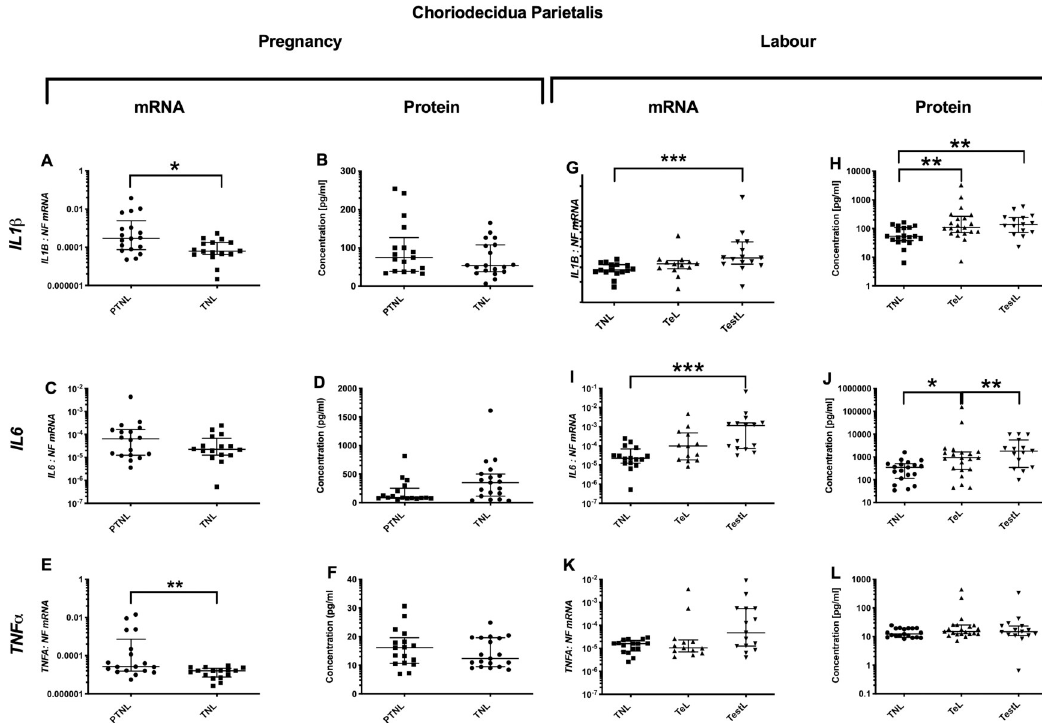
Fig 7. Pro-inflammatory changes in the choriodecidua parietalis. The cytokine levels in the choriodecidua parietalis samples obtained from four groups of women (mean gestational age ± SD in each case), PTNL (33.8 ± 1.7weeks, n = 17), TNL (39.3 ± 0.8 weeks, n = 19), TeL (38.4 ± 1.3weeks, n = 21) and TestL (39.5 ± 1.0, n = 15) were compared. Tissue levels of the cytokines were quantified using Bio-plex human cytokine 19-plex-array kit (Bio-rad) and a separate assay for CCL5 as describe in Materials and Methods . A subset of choriodecidua parietalis samples, PTNL (33.8 ± 1.7 weeks, n = 17), TNL (39.3 ± 0.9 weeks, n = 16), TeL (38.6 ± 1.2 weeks, n = 13) and TestL (39.5 ± 1.0, n = 15) were used to compare the mRNA expression using rtPCR of IL-1 β , IL6 and TNF α . Normally distributed data were analysed using a Student’s t-test for two groups and an ANOVA followed by a Dunnett’s or Bonferroni’s post-hoc test for three groups or more. Data that were not normally distributed were analysed using a Mann Whitney test for 2 groups and when comparing three groups or more a Friedman’s test, with a Dunn’s multiple comparisons post-hoc test. The data are shown as median with interquartile range. The p values are demonstrated by � is p < 0.05 and �� is p <